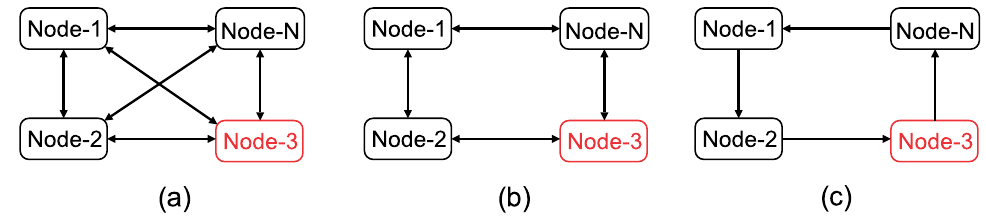
Figure 35. Communication: ( a ) all-to-all, ( b ) neighboring, ( c ) sparse.